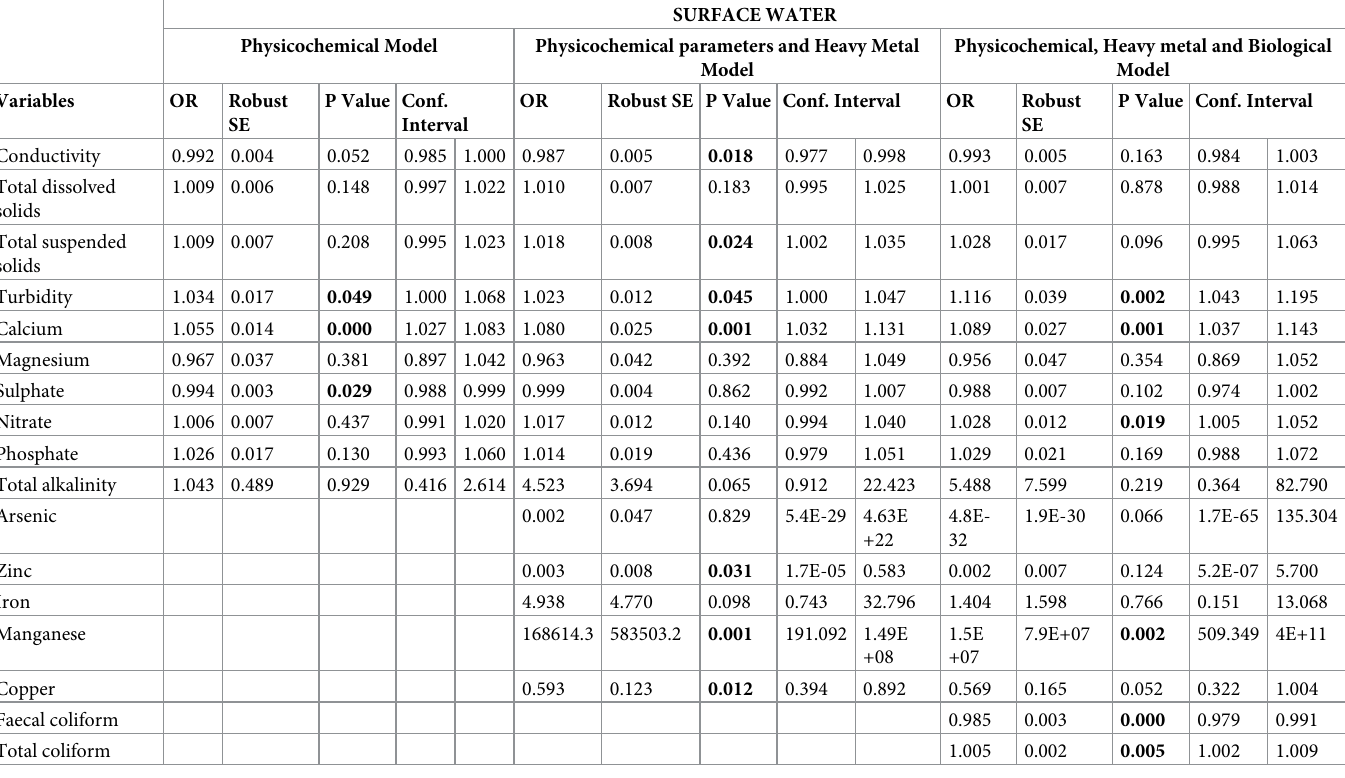
Table 6. Multivariate complementary log–log regression model predicting the relationship between pH and water quality parameters for surface